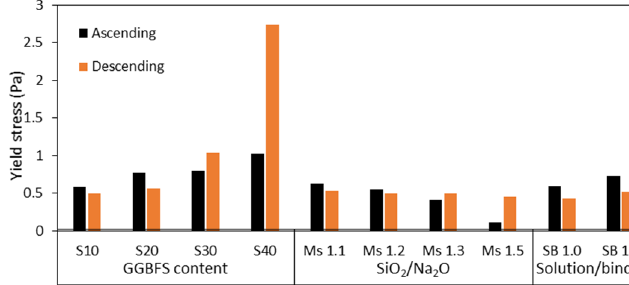
Figure 2. Bingham model yield stress of AAM pastes obtained from the ascending and descending